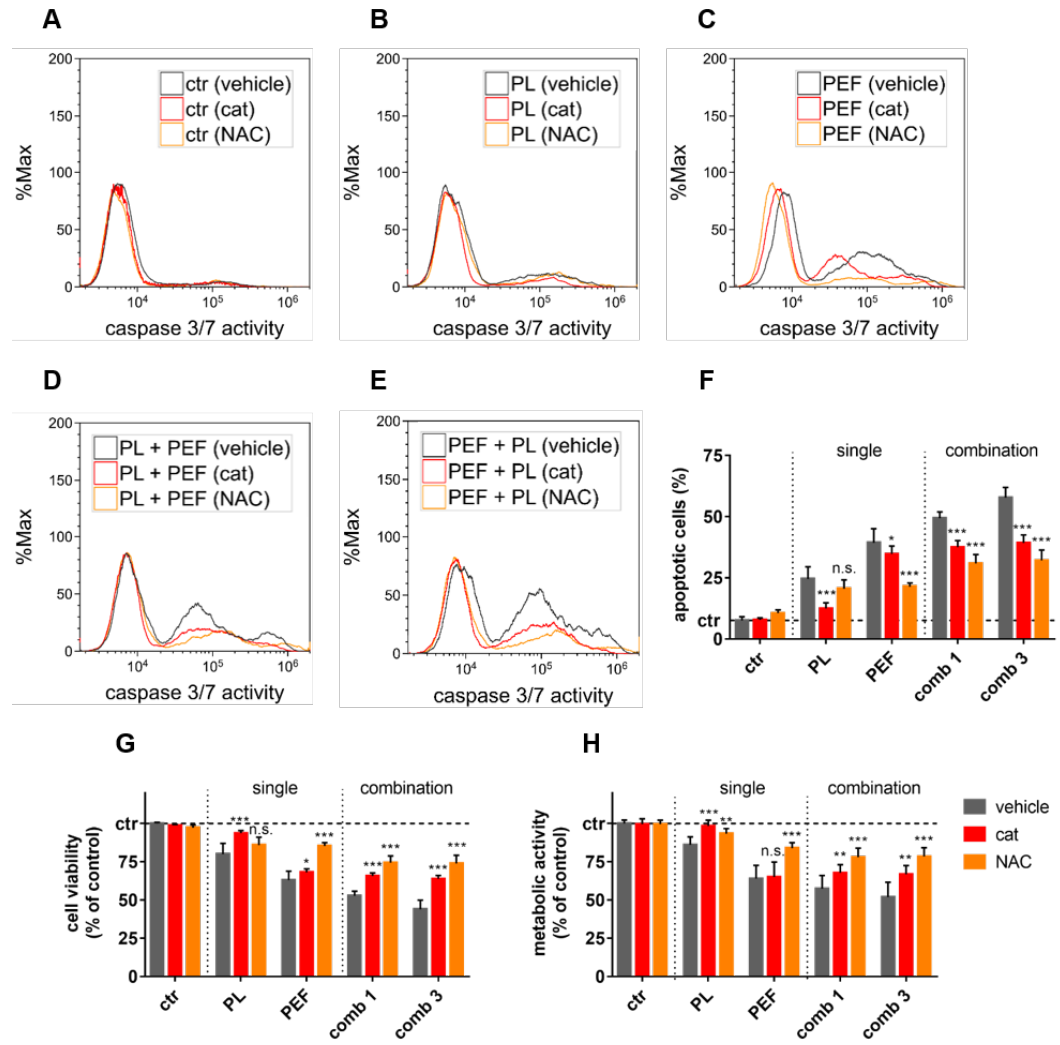
Figure 5. The effect of ROS scavenging in plasma and PEF treatments. The plasma exposure time was 40 s, and the electric field strength was 0.9 kV/cm. The cells were pretreated with catalase (cat) or N-acetylcysteine (NAC) and stained with CellEvent Caspase-3/7 Green Detection Reagent at 24 h in the control condition ( A ), or after plasma treatment ( B ), PEF treatment ( C ), plasma plus PEF treatment ( D ), or PEF plus plasma treatment ( E ). The apoptotic cells (caspase 3/7 active cells) were quantified 24 h after the treatments ( F ), as well as the cell viability ( G ) and the metabolic activity ( H ). The significant differences of cells without any antioxidants compared to the cat and NAC pretreated cells were determined by t-test. Data are shown as one representative ( A–E ) or mean + S.E. ( F–H ) of three independent experiments. ctr = control; PL = plasma; PEF = pulsed electric fields; comb = combination; n.s. = not significant.